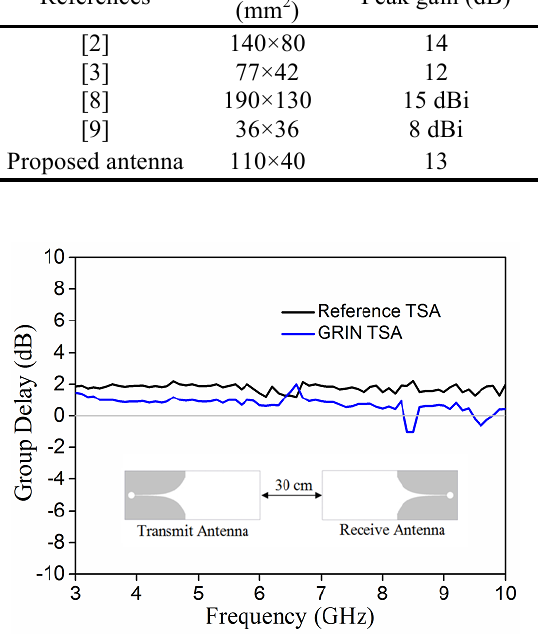
Figure 13: Measured group delay performance of the GRIN